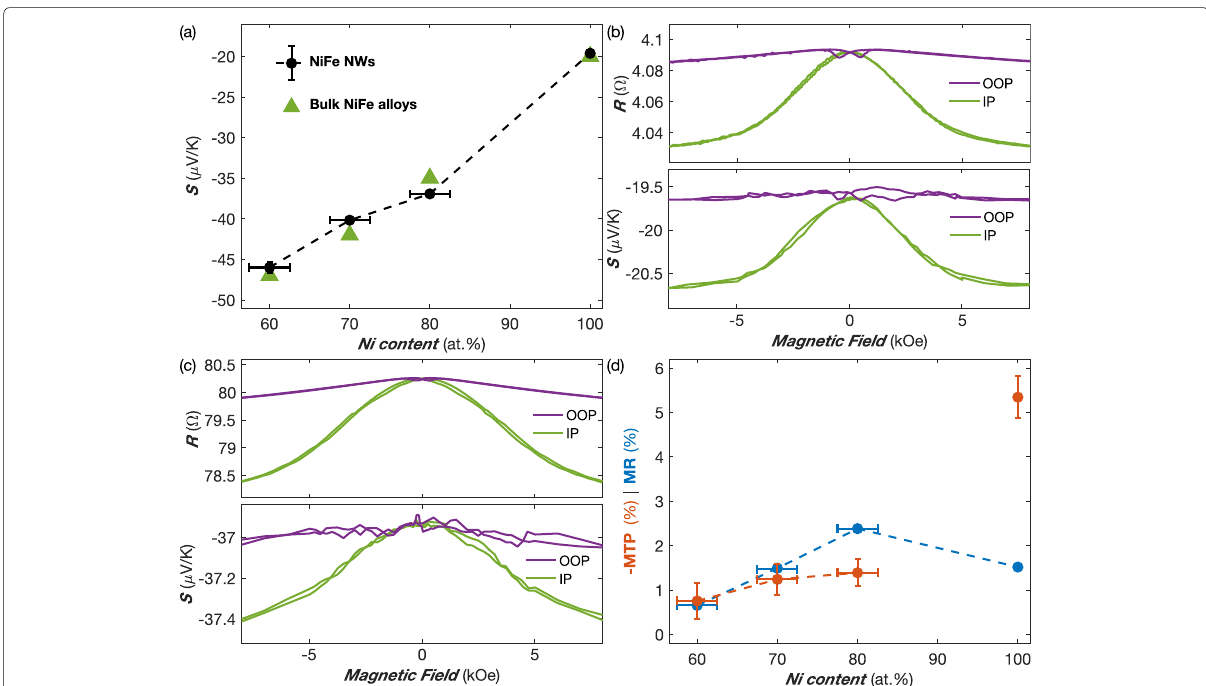
Fig. 2 a Variation of the Seebeck coefficient vs Ni content in NiFe NW networks (80-nm diameter) at room temperature. Recommended values for bulk alloys [38] are also reported. b , c Room temperature variation of the electrical resistance and Seebeck coefficient of Ni ( b ) and Py ( c ) NW samples obtained with the applied field in-plane (IP) and out-of-plane (OOP) of the NW network film. d MR and MTP ratios as a function of Ni content in NiFe NW networks at